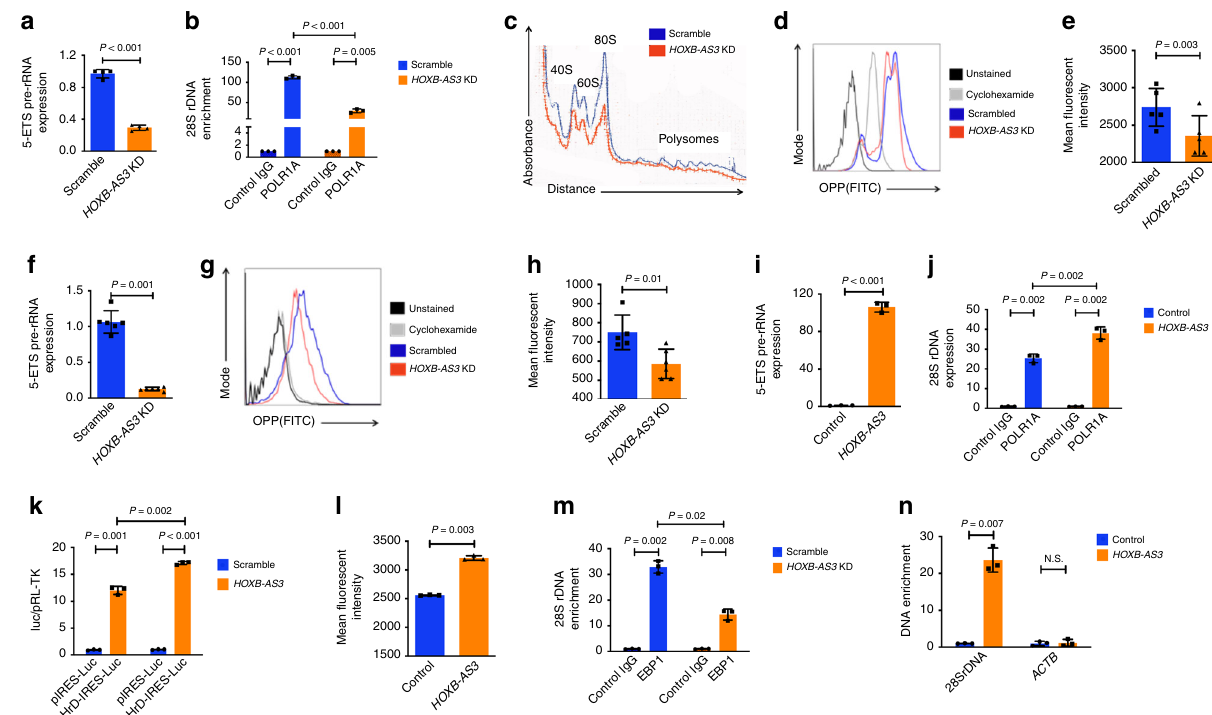
Fig. 5 HOXB-AS3 regulates rRNA transcription via guiding the EBP1 protein to the rDNA locus. a Relative pre-rRNA expression in OCI-AML3 cells treated with scramble or anti- HOXB-AS3 gapmers. b Occupancy of ribosomal DNA promoter repeat sequence (28S rDNA) by POLR1A in scramble versus HOXB- AS3 KD OCI-AML3 cells. c Sucrose gradient-based isolation and quanti fi cation (via ultraviolet radiation absorbance) of ribosomes and polysomes in scramble versus HOXB-AS3 KD OCI-AML3 cells. d Effect of HOXB-AS3 depletion on de novo protein synthesis in OCI-AML3 cells,The fl ow cytometry graph from one representative experiment is shown. e Comparison of the mean fl uorescence intensity of the Alexa Fluor 488-positive OCI-AML3 cells treated with scramble versus HOXB-AS3 KD, in de novo protein synthesis assays. Results of four independent experiments are shown. f Relative 5-ETS pre- rRNA expression in human AML patient blasts treated in vivo with scramble versus anti- HOXB-AS3 gapmers. Results of three scramble and four HOXB-AS3 KD-treated mice are depicted in aggregate. g , h Effect of HOXB-AS3 KD on de novo protein synthesis in in vivo treated human AML blasts . i Relative pre- rRNA expression in K-562 cells transfected with empty vector (control) or HOXB-AS3 overexpressing vectors. j Occupancy of 28S rDNA by POLR1A in K- 562 cells transfected with control or HOXB-AS3 overexpressing vectors. k Relative luciferase-reporter (luc/pRL-TK) activity in K-562 cells transfected with empty control (pIRES-Luc) or rDNA-promoter-containing (pHrD-IRES-Luc) luciferase-reporter vectors, and control or HOXB-AS3 overexpressing vectors. l Comparison of the mean fl uorescence intensity of the Alexa Fluor 488-positive K-562 cells, transfected with control or HOXB-AS3 overexpressing vectors in de novo protein synthesis assays. Results of three independent experiments are shown. m Occupancy of 28S rDNA by EBP1 in scramble versus HOXB- AS3 KD OCI-AML3 cells. n Enrichment of 28S rDNA or the ACTB promoter region in RAP-DNA-based isolation of chromatin with control or HOXB-AS3 - hybridizing biotinylated probes . P values were calculated using paired two-sided t -tests. In the fi gures, heights of boxplots indicate mean values with standard deviation. Error bars indicate highest and lowest values in each population. Source data are provided as a Source Data fi empty control (pIRES-Luc) and the rDNA promoter-containing To test this hypothesis, we studied the interaction of EBP1 with (pHrD-IRES-Luc) reporter vectors. K-562 cells transfected with the rDNA promoter in the presence or absence of HOXB-AS3 . the pHrD-IRES-Luc showed an approximately 10-fold increase HOXB-AS3 KD reduced the amount of EBP1 that was bound to in the relative reporter activity, compared with cells transfected the rDNA promoter, as measured by ChIP assays ( P = 0.02; with the pIRES-Luc. This increase was signi fi cantly higher when Fig. 5m). This effect was rDNA speci fi c and binding of EBP1 on K-562 cells were concomitantly transfected with a HOXB-AS3 - the E2F1 gene promoter, which has previously identi fi ed as an overexpressing vector versus an empty pcDNA3 vector control EBP1 target 44 was not affected by HOXB-AS3 KD (Supplemen- tary Fig. 11). We also evaluated the occupancy of the rDNA ( P = 0.002; Fig. 5k). Finally, HOXB-AS3 overexpression led to an promoter by the NPM1 protein and found that HOXB-AS3 KD increase in the de novo protein synthesis of the transfected K-562 cells ( P = 0.001; Fig. 5l).